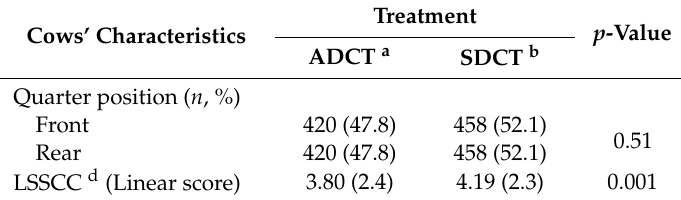
Cows’ Characteristics